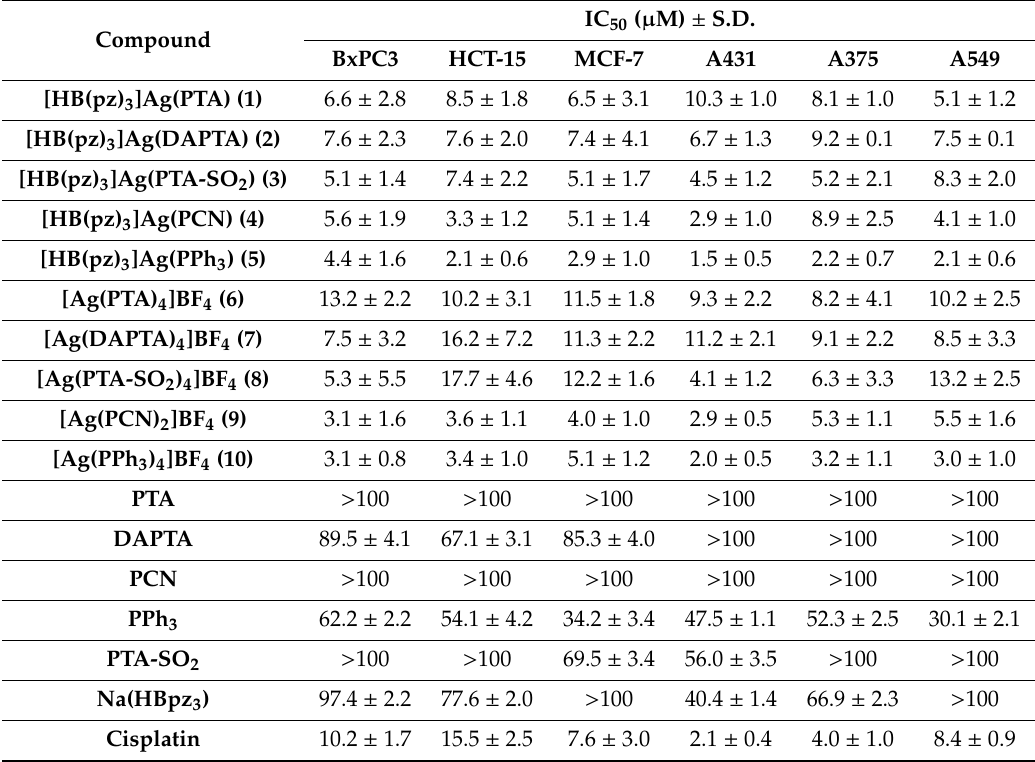
Table 2. Cytotoxicity assays. Cells (3–8 × 10 3 · mL − 1 ) were treated for 72 h with increasing concentrations of tested compounds. Cytotoxicity was assessed by MTT test. IC 50 values were calculated by a four parameter logistic model ( p < 0.05). S.D. = standard